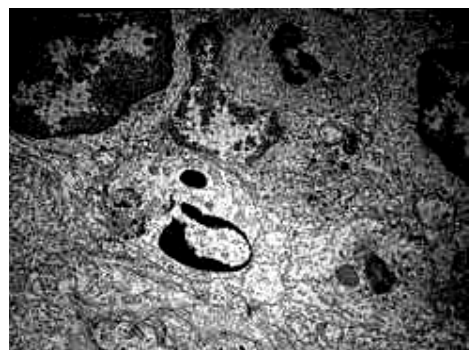
Fig. 6. Electronogram. Apoptosis of cells in the thymus